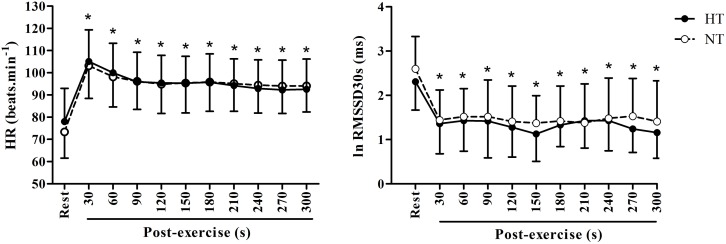
Heart rate (HR) and heart rate variability (RMSSD30s index) at rest and during 5 min of recovery (post-exercise). HT, hypertensive group; NT, normotensive group; * significantly different from rest in both groups (p < 0.05).